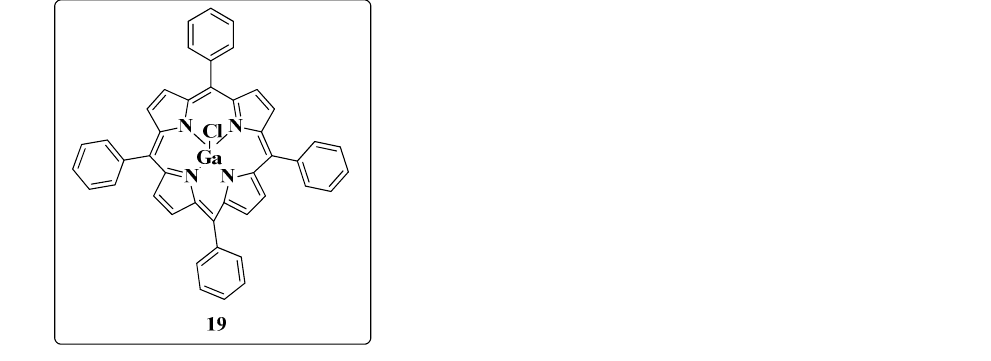
Figure 18. Chemical structure of the gallium nanoparticle (Ga-NP) 19 (tetraphenyl porphyrin of